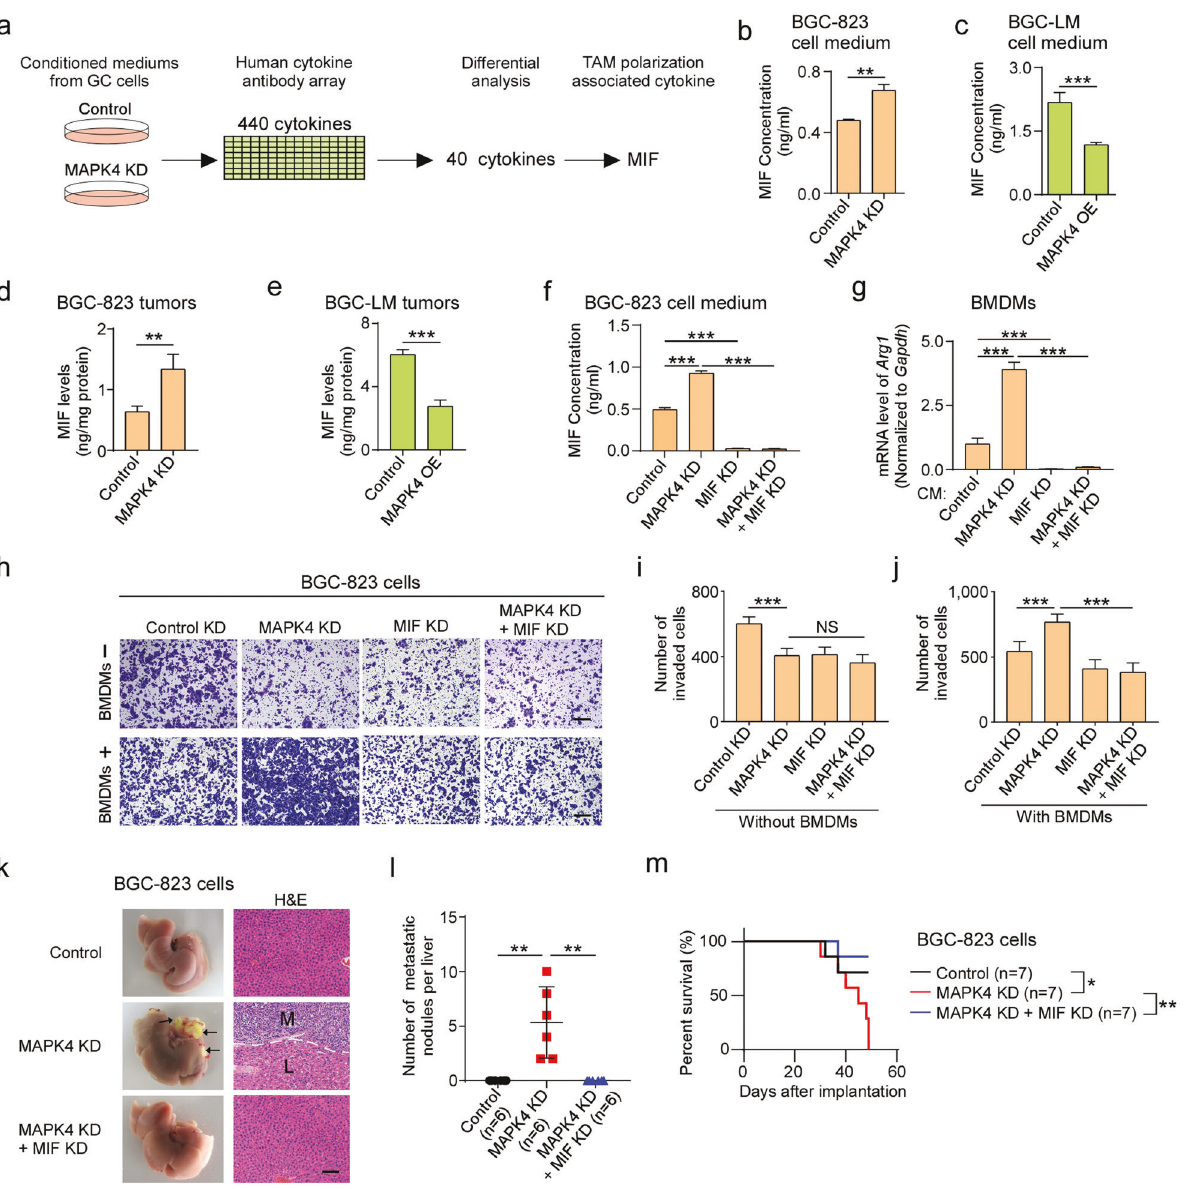
Fig. 5 MAPK4 downregulation increases MIF secretion to activate TAMs. a Screening of cytokines to promote TAM polarization from conditioned media of control and MAPK4-depleted BGC-823 cells. b Quantitative analysis of the MIF levels in conditioned media from control and MAPK4-depleted BGC-823 cells by ELISA. c Quanti fi cation of the MIF levels in conditioned media from control and MAPK4-overexpressing BGC-LM cells by ELISA. d Quantitative analysis of the MIF levels in orthotopic tumors of BGC-823 cells depleted of MAPK4 by ELISA. e Quanti fi cation of the MIF levels in orthotopic tumors of BGC-LM cells overexpressing MAPK4 by ELISA. f Analysis of the MIF levels in conditioned media from BGC-823 cells with the indicated treatments by ELISA. g Quantitative RT-PCR analysis of Arg1 mRNA in BMDMs cocultured with BGC-823 cells with the indicated treatments. h – j BGC-823 cells with the indicated treatments were used for Matrigel invasion analysis. The number of invaded cells per well was quanti fi ed. Scale bars, 200 μ m. k – m BGC-823 cells were depleted of the indicated genes and subjected to orthotopic implantation to induce the development of liver metastasis in SCID mice. Representative photographs of livers and H&E staining of the liver sections are shown ( k ). The metastatic nodules per mouse were counted ( l ). The arrows denote metastatic nodules. Scale bars, 100 μ m. The indicated mice were also subjected to Kaplan ‒ Meier analysis (log-rank test) ( m ). The data are expressed as the means ± standard deviations. * p < 0.05, ** p < 0.01, *** p < 0.001; NS not signi fi cant (Student ’ s t